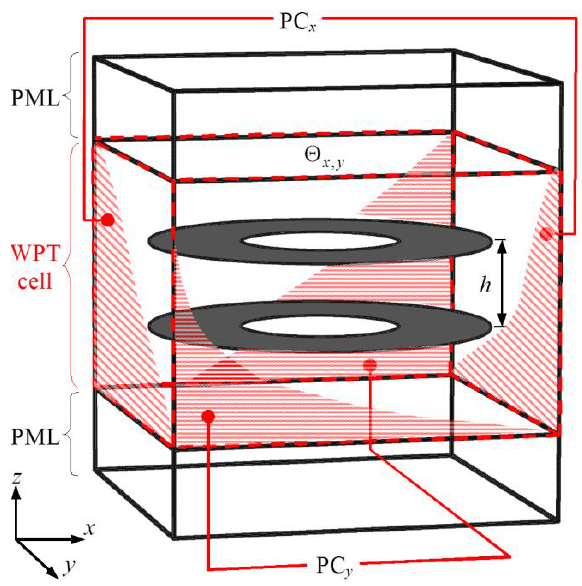
Figure 4. Numerical model of the periodic WPT system.